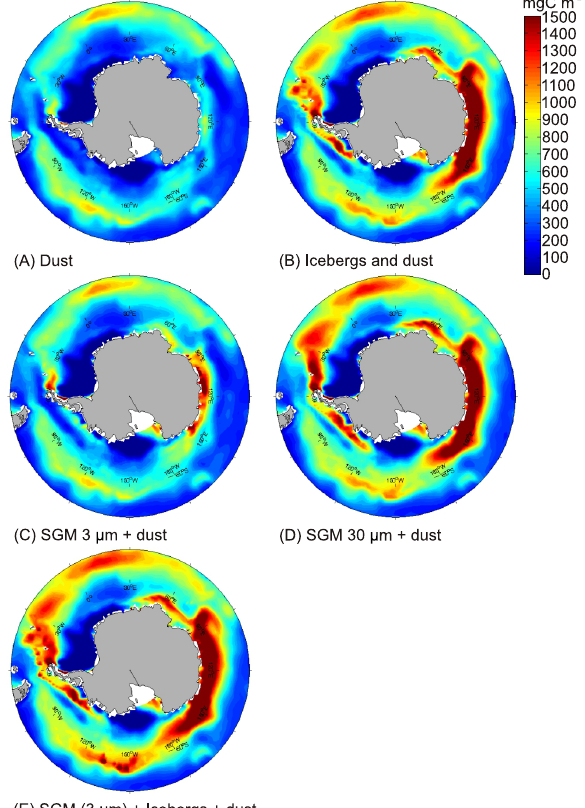
Figure 5. Modelled mean seasonal primary productivity (Decem- ber, January, February) of the Southern Ocean in response to dust and glacial iron inputs for model scenarios (A) aeolian dust, (B) icebergs, (C) SMW, where [Fe] = 3µM, (D) SMW, where [Fe] = 30µM and (E) Aeolian dust + icebergs + SMW (where [Fe] =